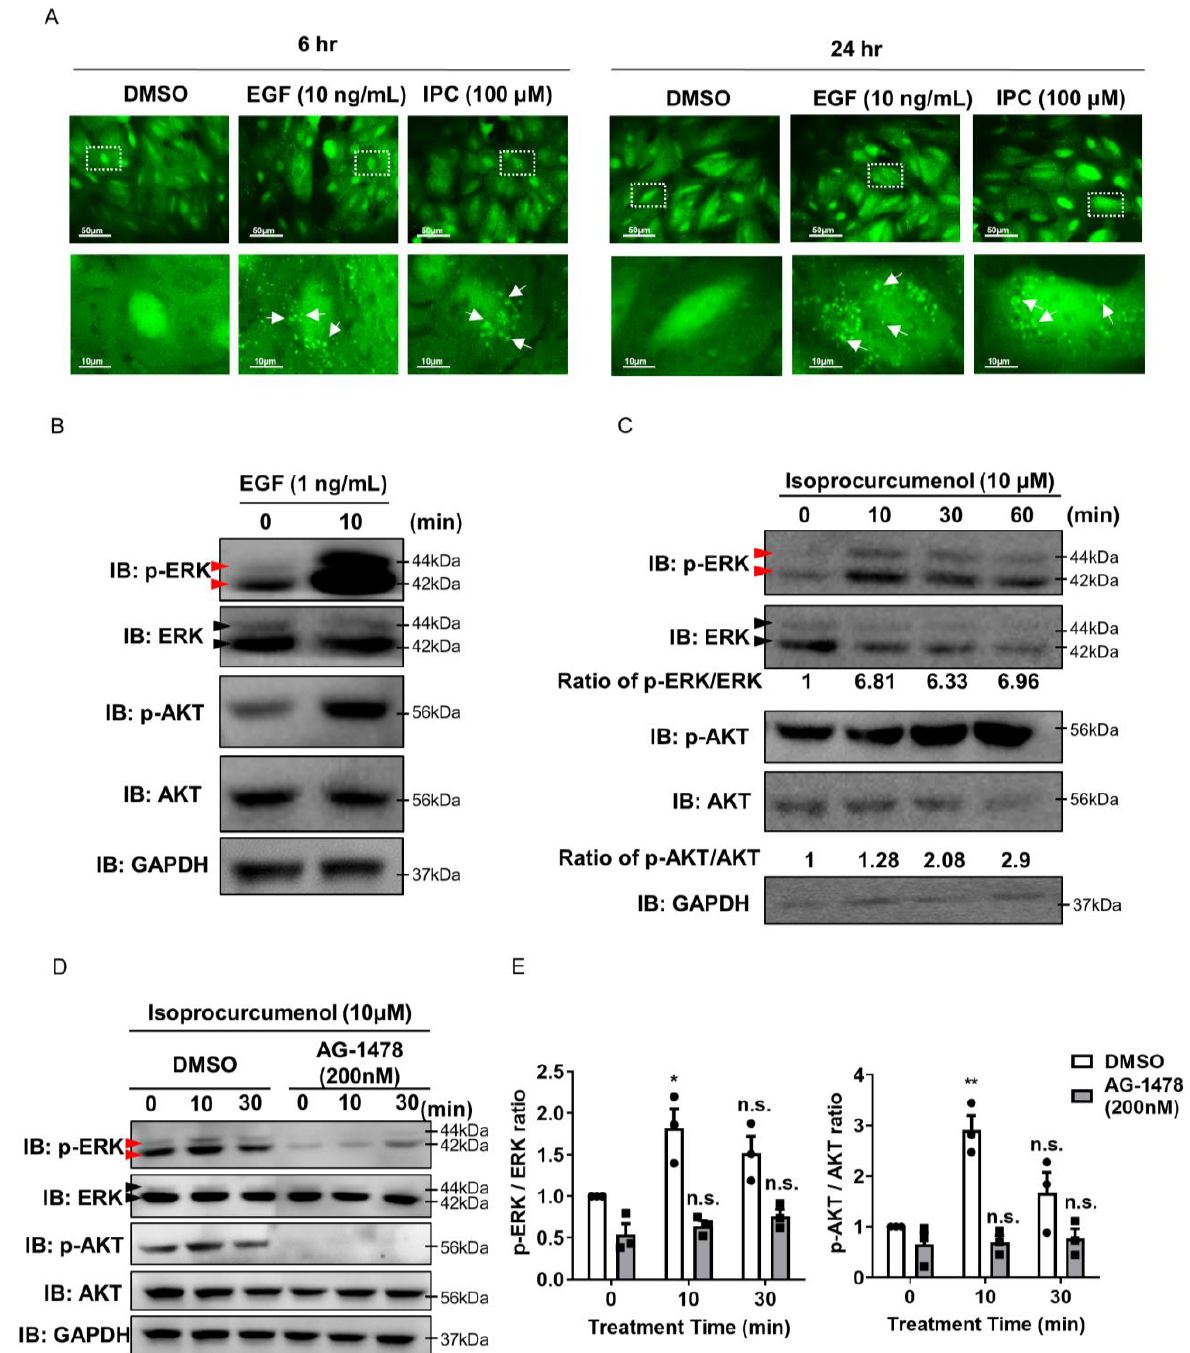
Figure 1. Recognizing isoprocurcumenol as an EGF analogue, using a biosensor system that measures EGFR activity. ( A ) A549 cells that stably express a biosensor system for EGFR activity were used to observe IPC as an EGF analogue. Treatment with IPC for 6 or 24 h induced GFP spots in modified A549 cells. The GFP spots are indicated with white arrows. DMSO was used as a negative control, while EGF (10 ng/mL) was used as a positive control. ( B ) Immunoblot of p-ERK and p-AKT after EGF treatment. HaCaT cells were treated with EGF (1 ng/mL) for 10 min and were subjected to Western blot analysis. Total ERK and AKT were used for normalization. Red arrows indicate phosphorylated ERK 42/44, while black arrows indicate total ERK 42/44. ( C ) Immunoblot of p-ERK and p-AKT after IPC treatment. HaCaT cells were treated with IPC for 10, 30, or 60 min and were subjected to Western blot analysis. Total ERK and AKT were used for normalization. Red arrows indicate phosphorylated ERK 42/44, while black arrows indicate total ERK 42/44. ( D , E ) Representative immunoblotting ( D ) and the quantification ( E ) of IPC-treated p-ERK and p-AKT after the inhibition of EGFR signaling. HaCaT cells were treated with DMSO or AG-1478, an EGFR antagonist, before treatment with IPC. Total ERK and AKT